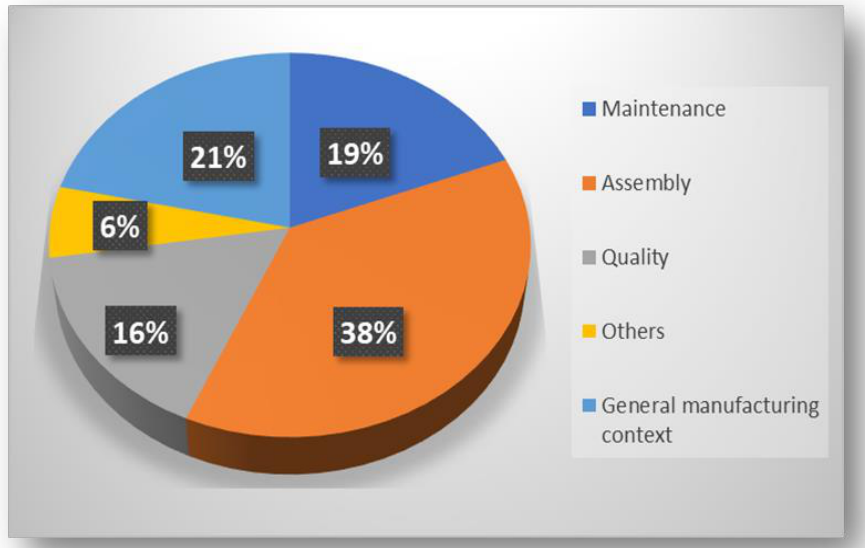
Figure 7. Distribution of application field in manufacturing.